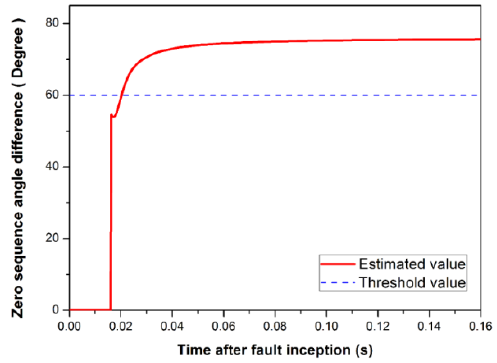
Figure 21. Angle difference during a microgrid fault in autonomous mode.